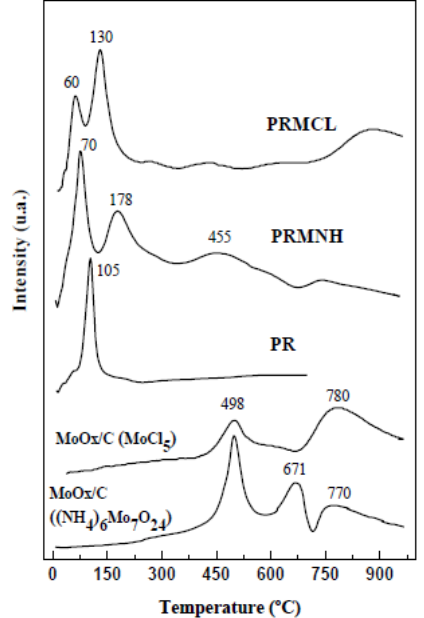
Figure 3. Temperature programmed-reduction (TPR) profiles of samples. Adapted from Tsiouvaras et al.